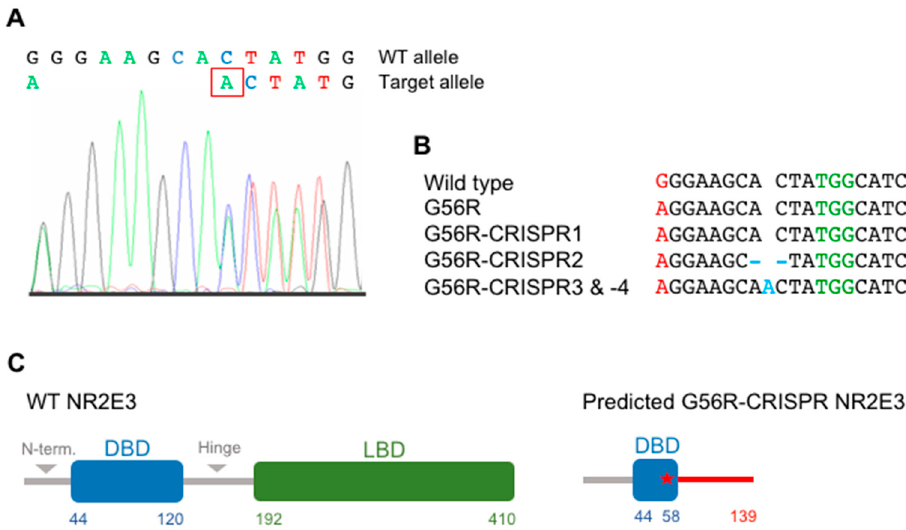
Figure 3. Generation of G56R-CRISPR iPSC lines. ( A ) Representative electropherogram of the sequence flanking the DSB site in the DNA of the G56R-CRISPR3 and -4 iPSC clones. The sequence begins at the c.166G>A mutational site. The introduced nucleotide (c.174insA) is boxed in red. ( B ) Alignment of the Sanger sequencing results for the same region shown in ( A ) in the wild type, G56R and four G56R-CRISPR IPSC clones. The mutational site is shown in red. The indels are indicated in blue. The PAM sequence is shown in green. ( C ) Graphical representation of the protein structure of 410 aa WT NR2E3 (left) with the DNA binding domain (DBD) shown in blue, the ligand binding domain (LBD) shown in green and the N-terminus and the hinge region are shown in grey. The predicted effect on NR2E3 (right) following introduction of the frameshift mutation on the G56R (indicated by a red star in the truncated DBD) mutant allele. The red bar indicates a non-NR2E3 protein sequence prior to the premature termination at 139 aa.